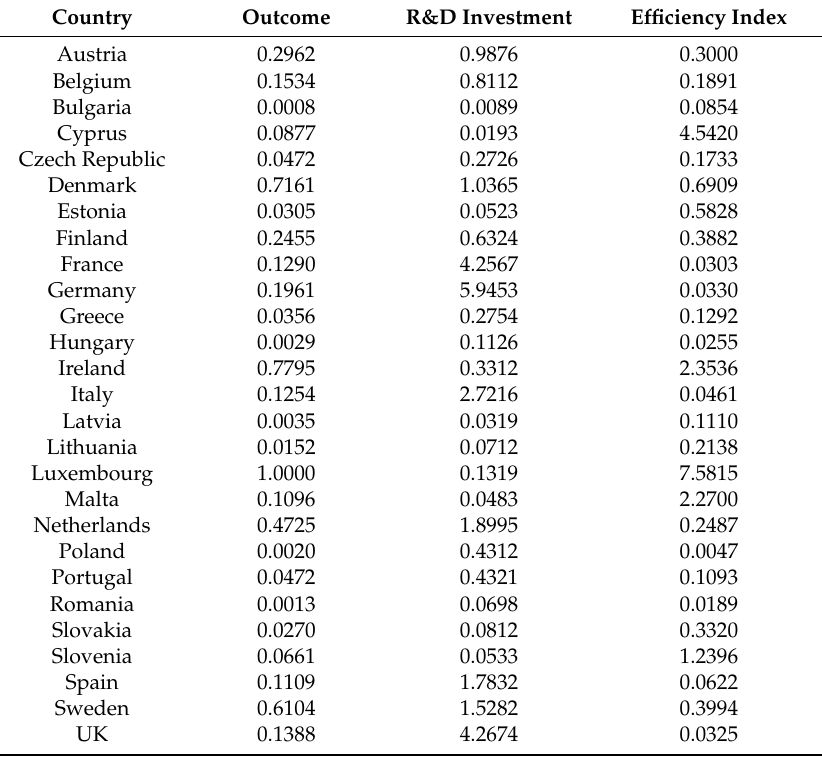
Table 6. Circular economy efficiency